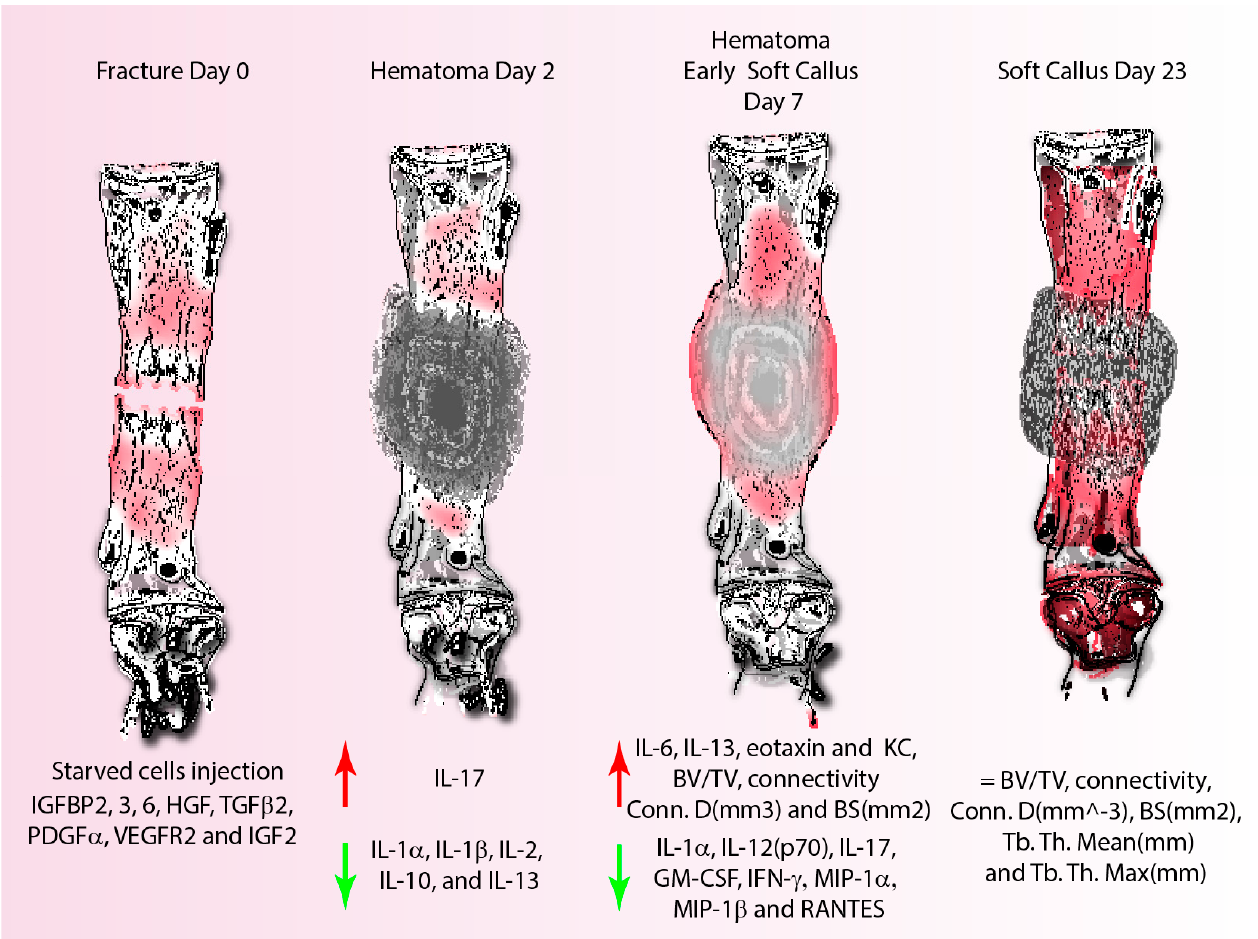
Figure 8. Graphic outlining the effects of hBM-MSC-starved cell injection on bone healing, as well as the released cytokines and growth factors involved in the early phases of fracture healing. Results demonstrate that the starvation process induces the production of different growth factors such as IGFBP2, 3, 6, HGF, TGF β 2, PDGF α , VEGFR2 and IGF2, which induce the secretion of cytokines such as IL-17 and repress the production of IL-1 α , β , 2, 10 and 13 at the earliest time-point. At day 7 after fracture, starved cells favor the expression of IL-6, 13 and KC, increase the presence of mineralized